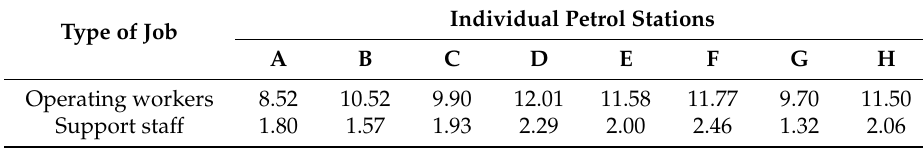
Table 3. Calculated LADD (mg/kg/day) at C m for MTBE exposure in operating workers and support staff ( ˆ 10 ´ 3 ).